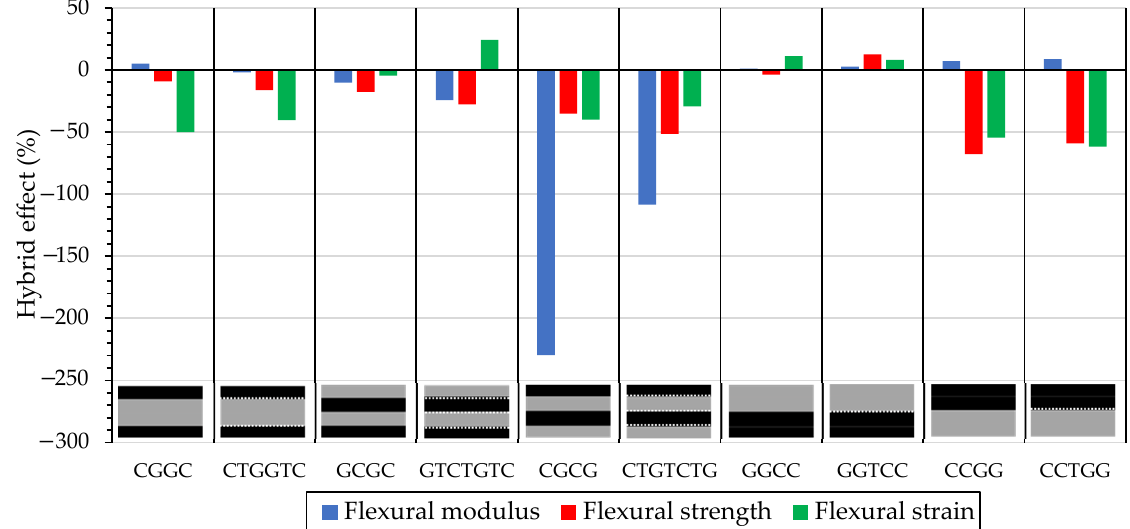
Figure 14. Rule of mixture comparison between hybrid stacking sequences and the veil toughened hybrid stacks.